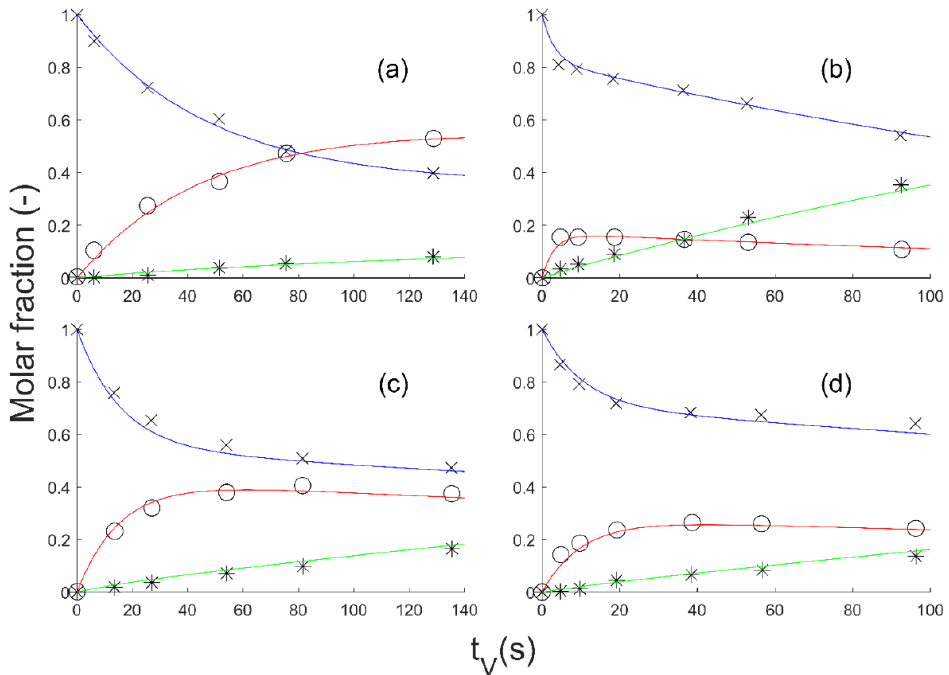
Figure 4. Simulation of the extrapolation of Model 3 with the adjusted parameters. GBL (experimental: times cross; model: blue line), BDO (experimental: circle; model: red line) and side products (experimental: star; model: green line) molar fraction vs. time on stream (t V ): ( a ) 35 bar, 200 °C; ( b ) 25 bar, 240 °C; ( c ) 35 bar, 220 °C; ( d ) 25 bar, 220 °C.